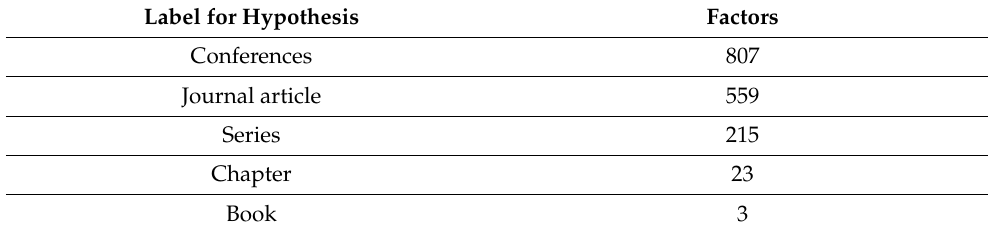
Table 2. Publication types of articles according to inclusion and exclusion criteria.